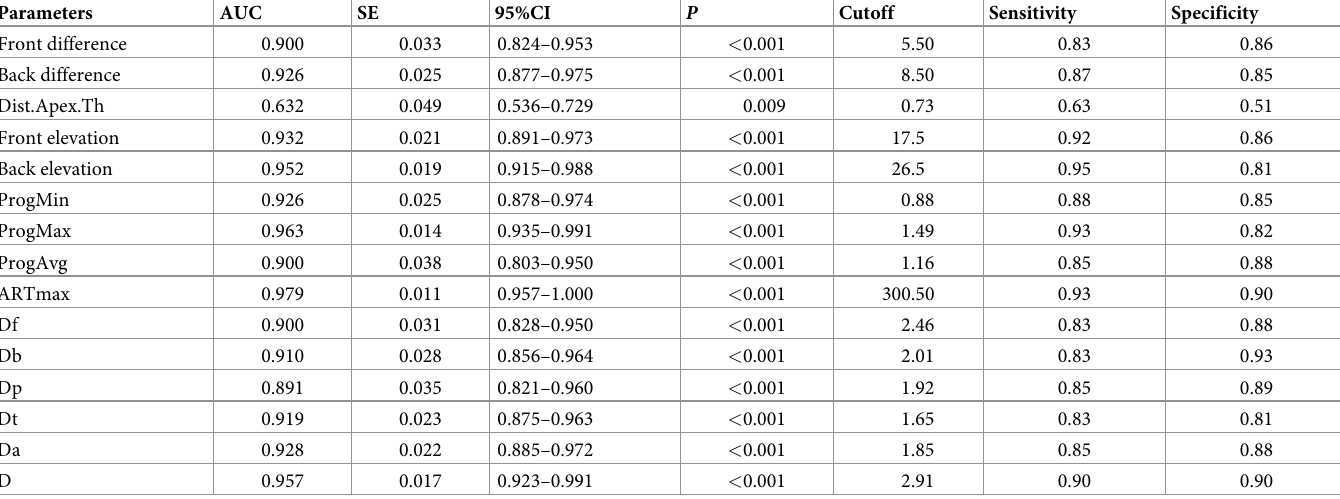
Dist.Apex.Th: distance from corneal apex to thinnest location, ProgMin/Max/Avg: progression index, ARTmax: maximum Ambrosio´ relational thickness, Df: deviation thickness, Da: deviation of ARTmax, D: total deviation